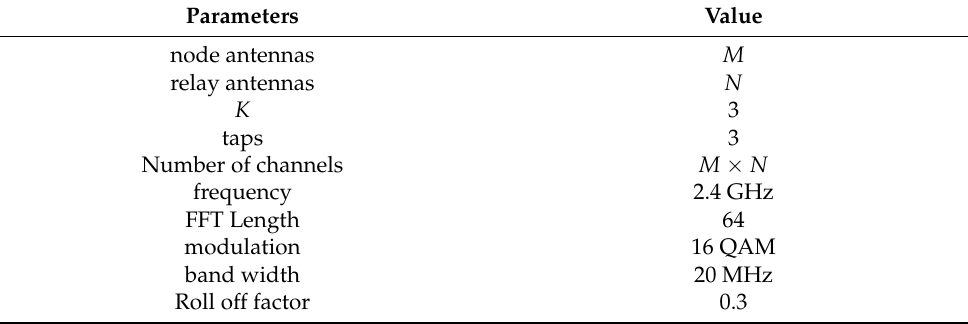
Table 1. Simulation